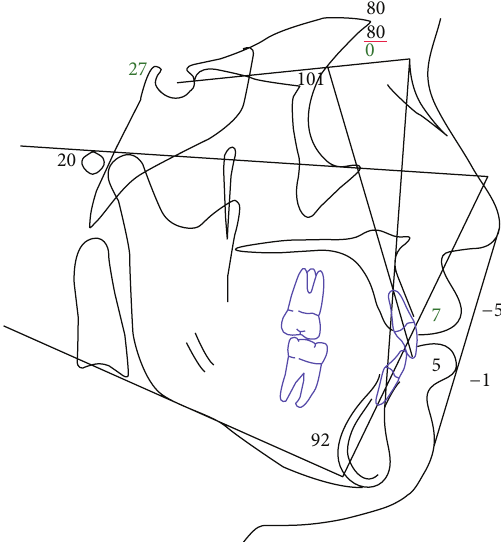
Figure 10: Final lateral cephalometric tracing.